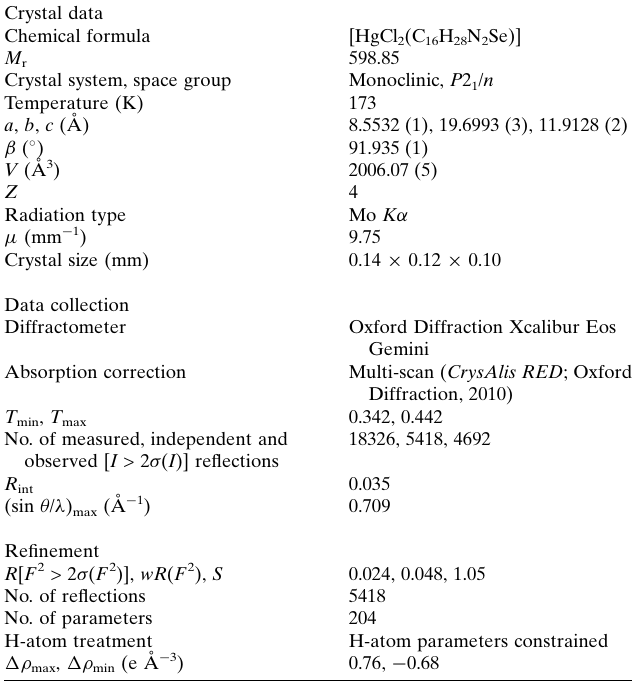
Crystal data Chemical formula